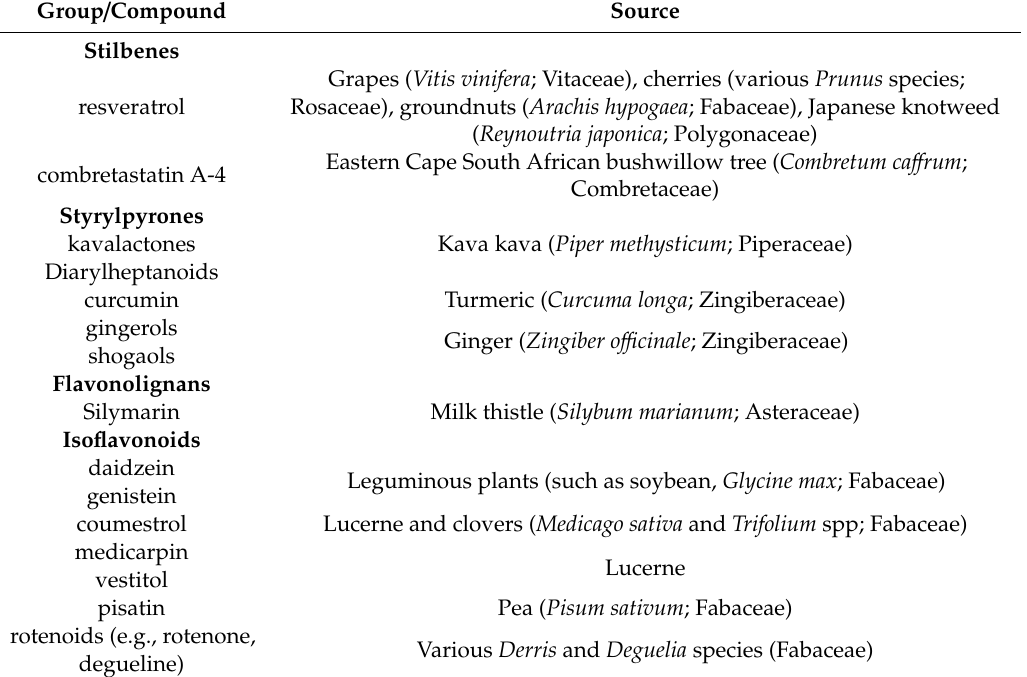
Table 2. Sources of aromatic polyketides with more restricted